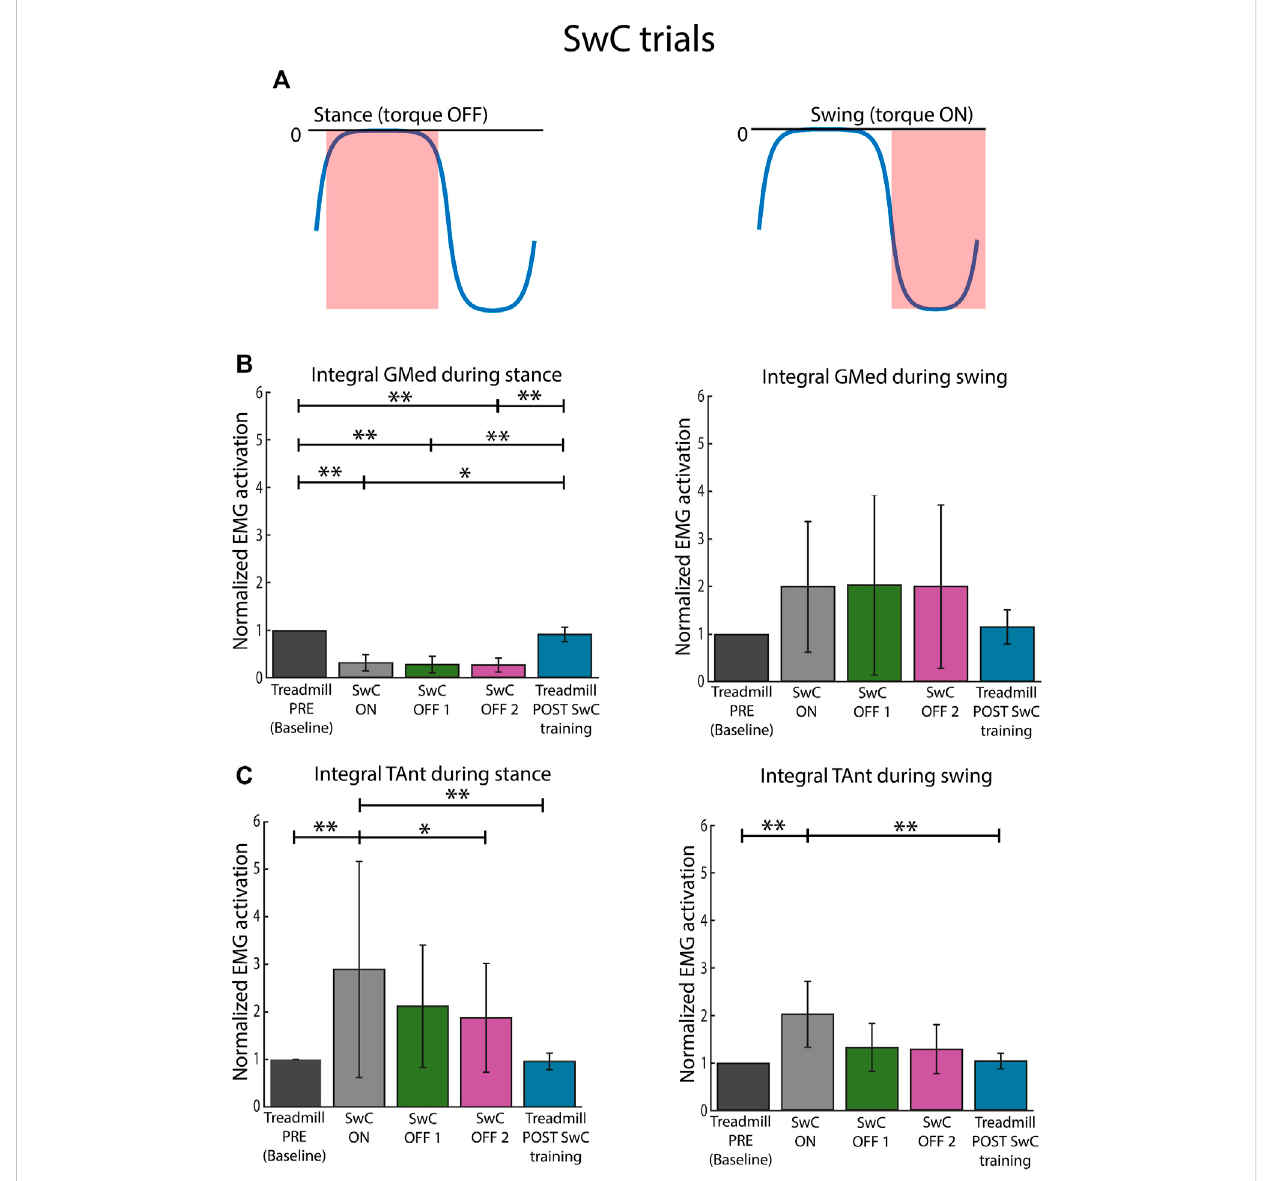
FIGURE 9 Normalized EMG activation across subjects for SwC and treadmill (PRE and POST SwC training) trials. (A) Torque pro fi le delivered during stance (no disturbances)andswingunderSwCdisturbances. (B) ActivationofGMedduringstance(leftpanel)andswing(rightpanel),normalizedtothebaseline, i.e. , Treadmill PRE. (C) Activation of TAnt during stance (left panel) and swing (right panel), normalized to the baseline, i.e. , Treadmill PRE. SwC ON corresponds to the fi rst 70 training cycles with the torque. SwC OFF 1 corresponds to training cycles 1 – 6 without the SwC torque. SwC OFF 2 corresponds to training cycles 7 – 16 without the SwC torque. Bars represent mean and standard deviation of the group. p < 0.05*; p <